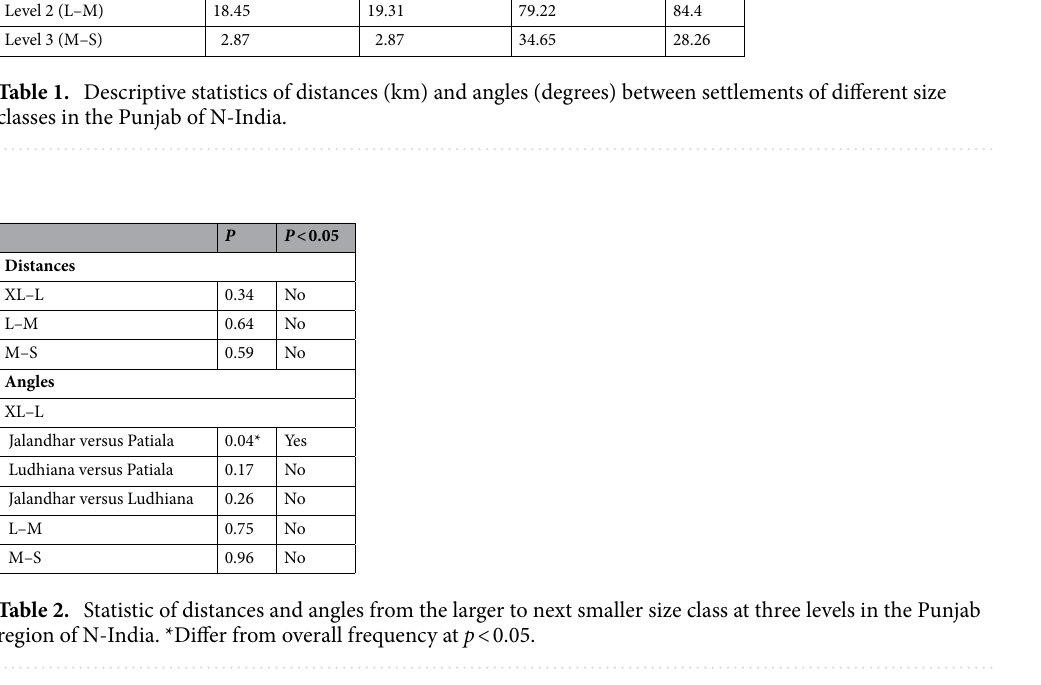
Distances (km) Angles (degrees) Average Median